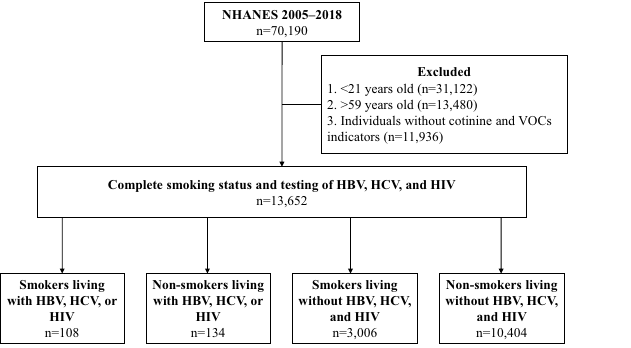
Figure 1. Flow chart of research subjects